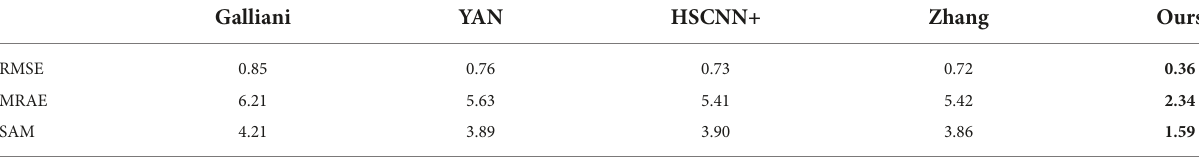
TABLE 4 Comparison of the spectral reconstruction errors of different methods under the illumination of non-uniformity point light source. Galliani